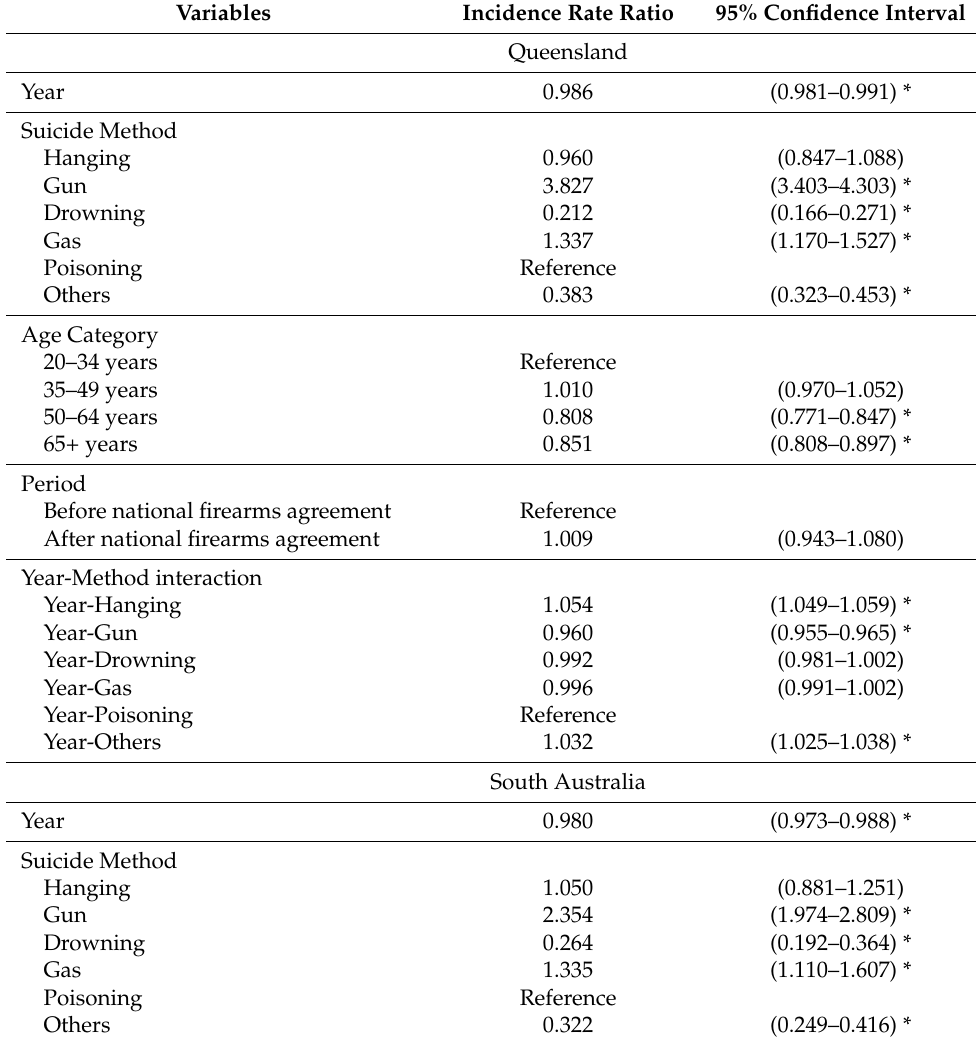
Table 2. Poisson regression analysis of suicide mortality in Queensland, South Australia and